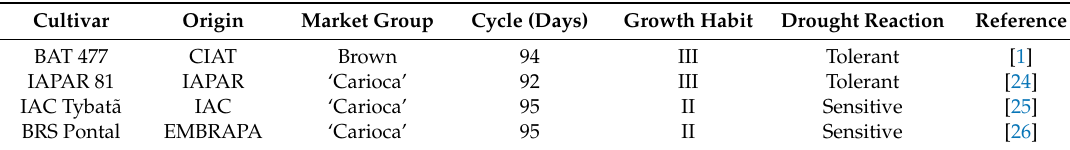
Table 1. Characteristics of common bean cultivars evaluated under water-stressed and unstressed